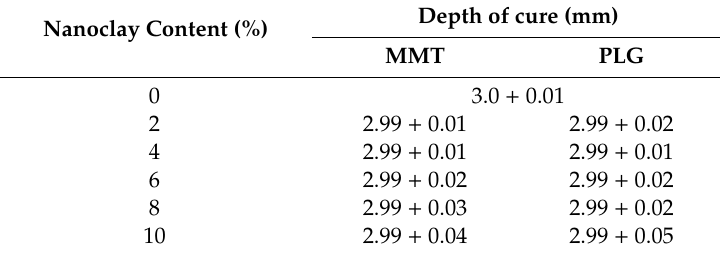
Table 3. Depth of cure of dental composites.